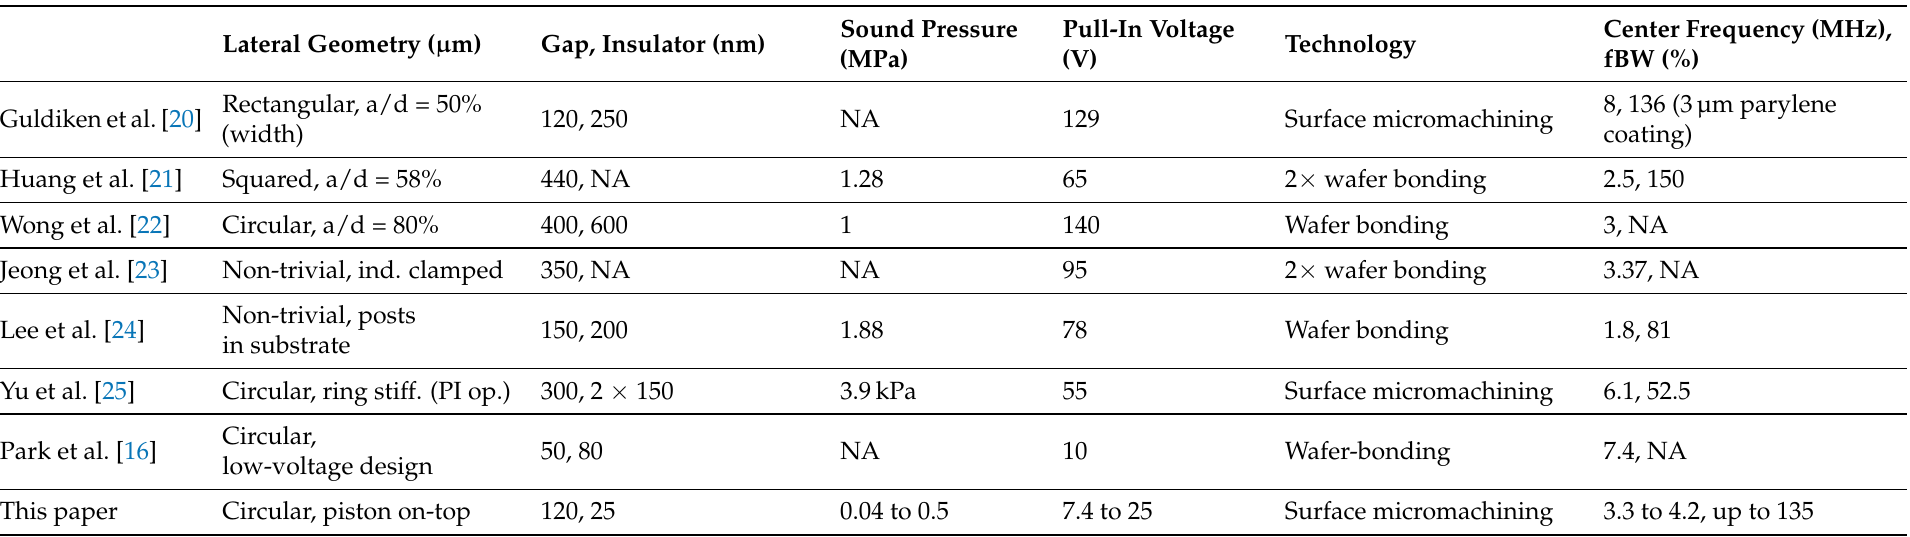
Table 1. Overview of CMUT properties of state-of-the-art designs for enhanced ultrasound